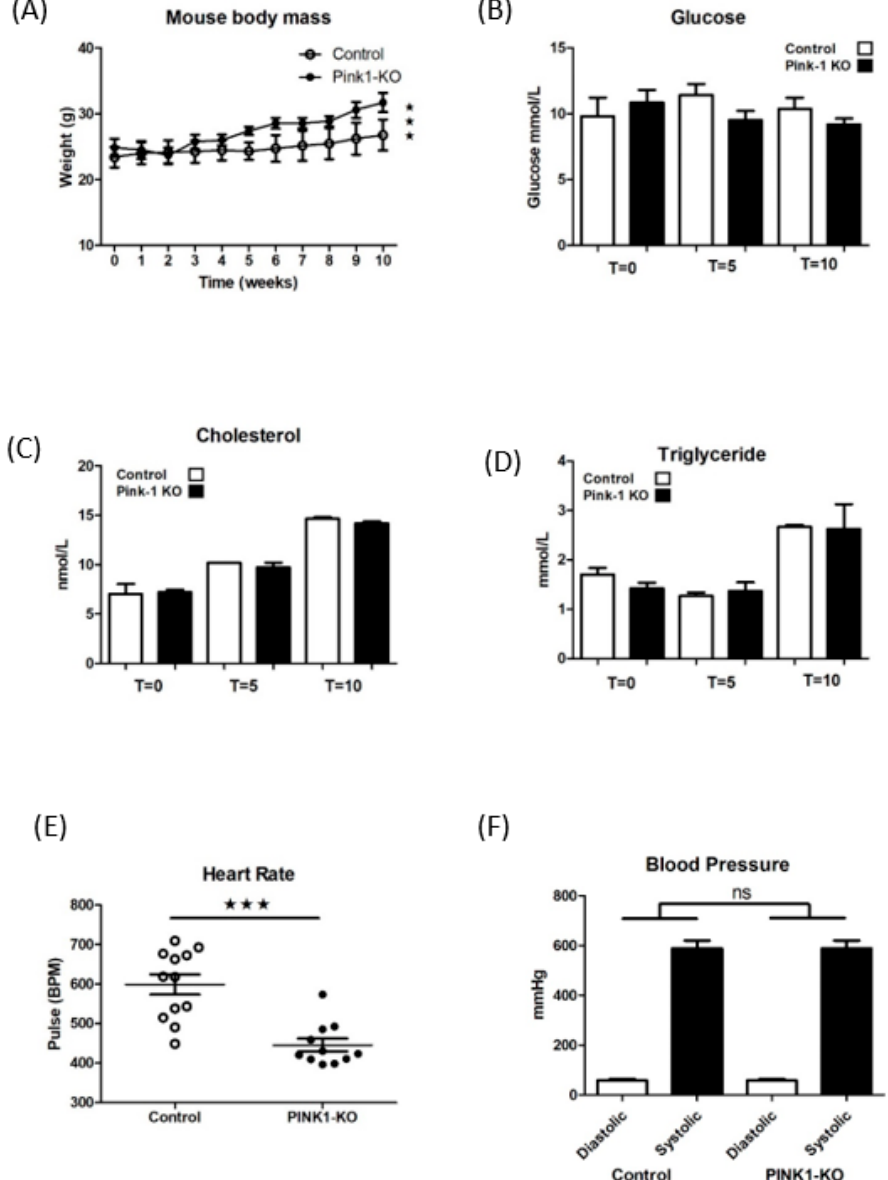
Figure 2. Pink1 mice body weight, serums and heart and blood pressures during high-fat feeding. ( A ) Body weights over experimental time course. ( B ) Blood serum values for glucose ( C ) cholesterol and ( D ) triglyceride across the high-fat feeding time course at T = 0, T = 5 and T = 10 weeks. ( E ) Mice heart rates @ T = 5 weeks. ( F ) Tail-cuff blood pressure values 5 weeks high-fat diet. Student t -test (n = 6) (ns—non significant), *** p ≤ 0.001. vs. control.